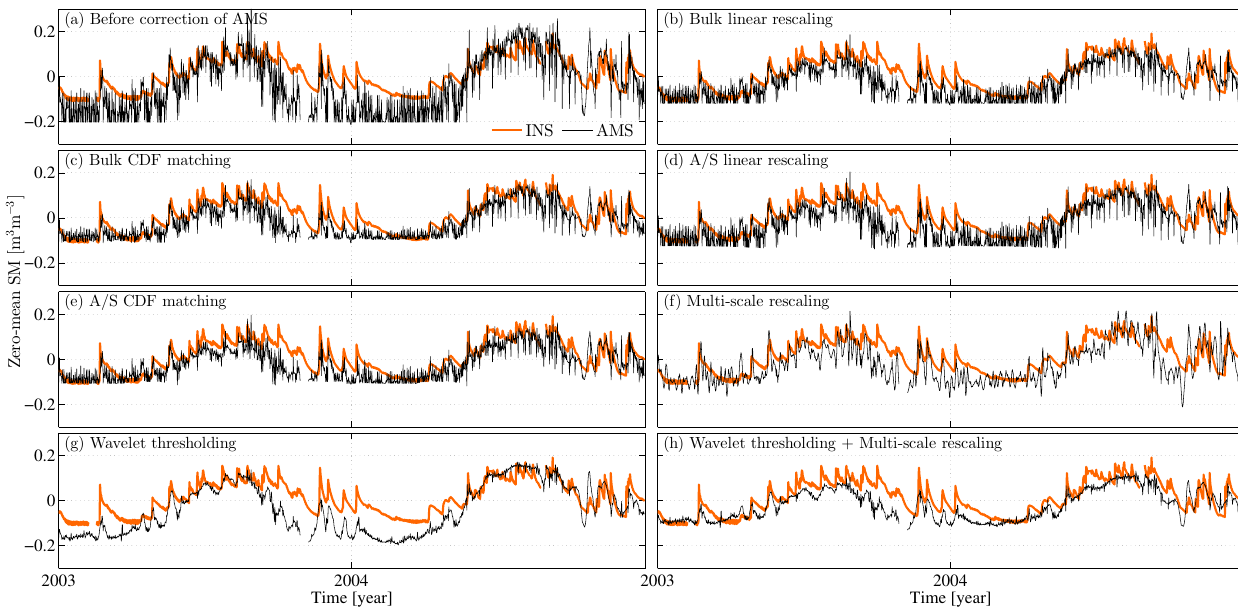
Figure 6. Time series of AMS SM at Kyeamba treated by various bias correction schemes. The use of WT-based de-noising has also been demonstrated in (g, h)